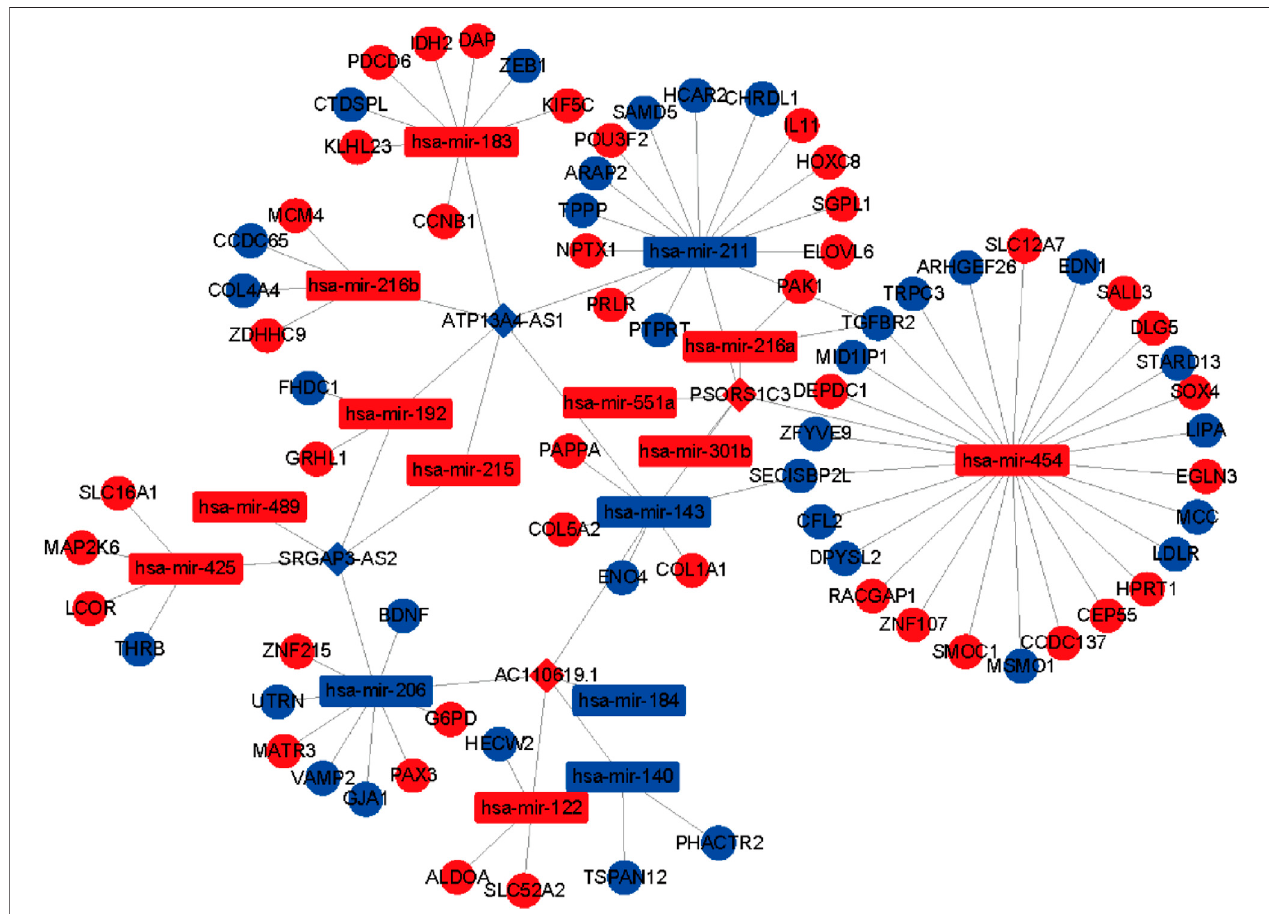
FIGURE 4 | Construction of the ceRNA network. Red and blue circles indicate upregulated and downregulated mRNAs, respectively. Red and blue rectangles indicate upregulated and downregulated miRNAs, respectively. Red and blue diamonds indicate upregulated and downregulated genomic instability – derived differentially expressed m 6 A-related lncRNAs,